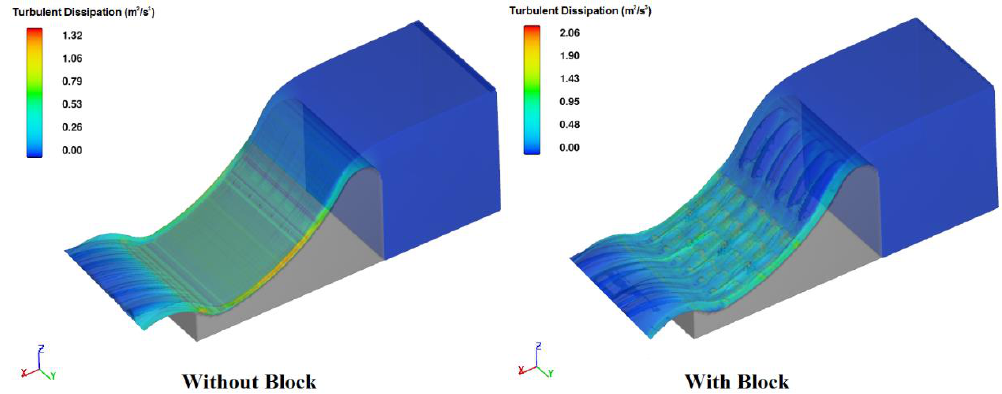
Figure 10. Comparison of flow turbulence on ogee-spillway chute with and without block bed.